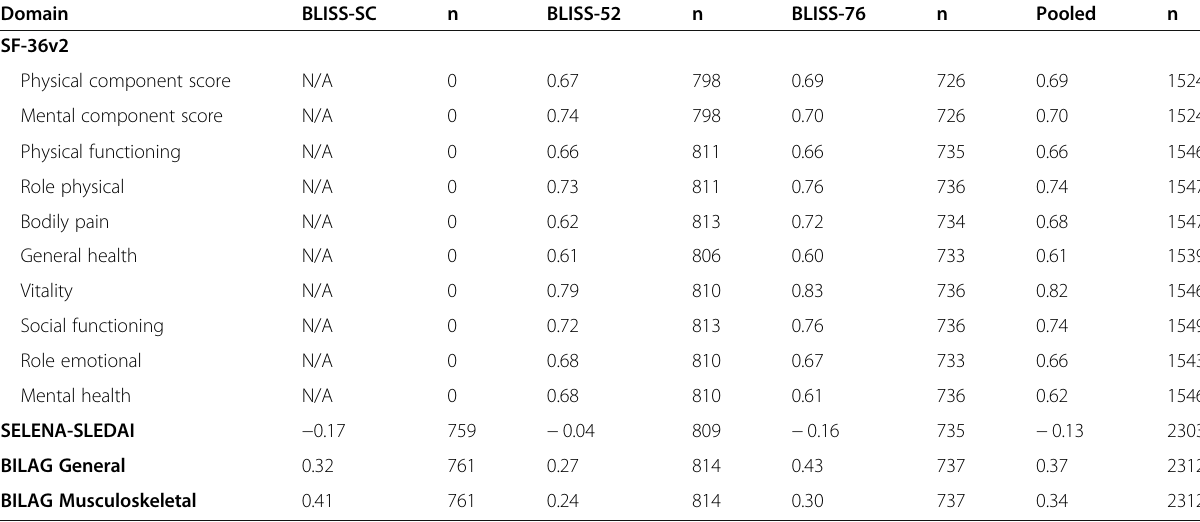
Table 2 Spearman correlations between FACIT-Fatigue and various measures (Week 24) Domain